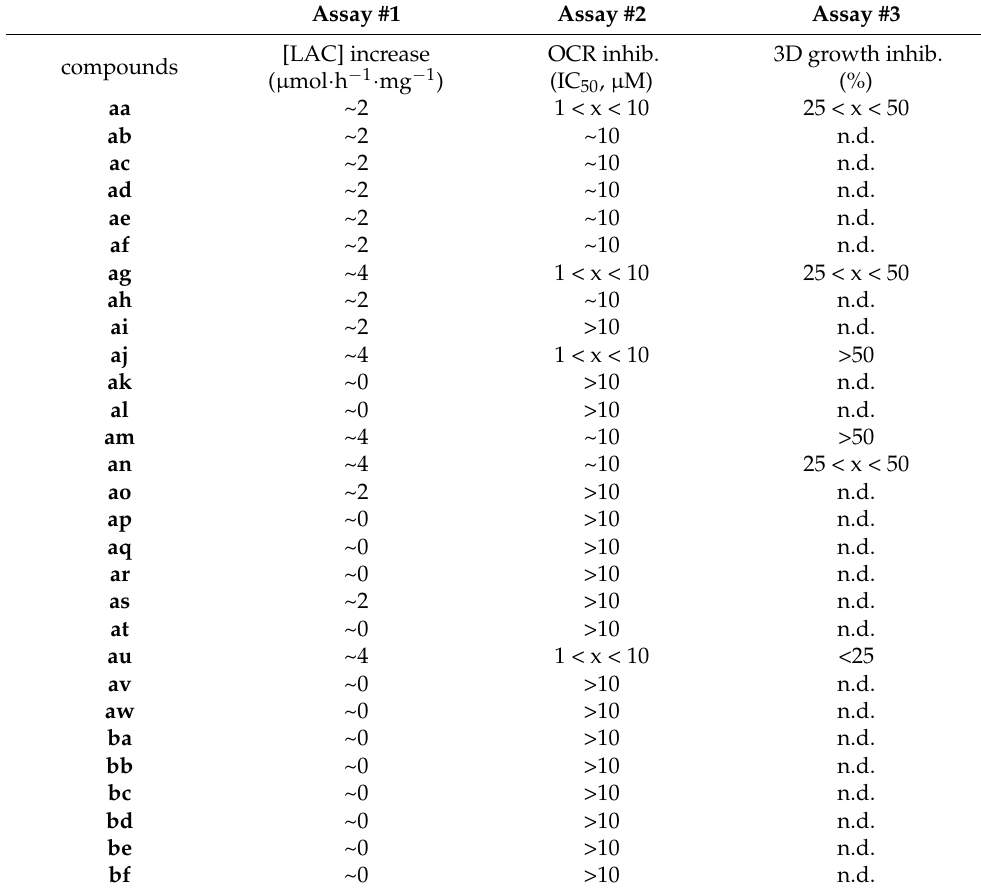
Figure 3. Compound-induced L-lactate release (Assay #1). Culture medium was collected after 24 h exposure to the indicated compounds (10 µ M) and the amount of extracellular L-lactate release was determined in a semi-automated manner; dose-dependent effects of complex I inhibitor IACS are shown on the right (shaded bars). Bar graph depicts the extent of L-lactate secretion above the basal release as determined in the absence of any compound (n = 3, ** p < 0.01 for increased L-lactate release vs. reference compound aa ). Table 2. Evaluation of the activity of aa compound derivatives in different screening assays. Assays 3D tumor spheroids growth inhibitory effects (assay